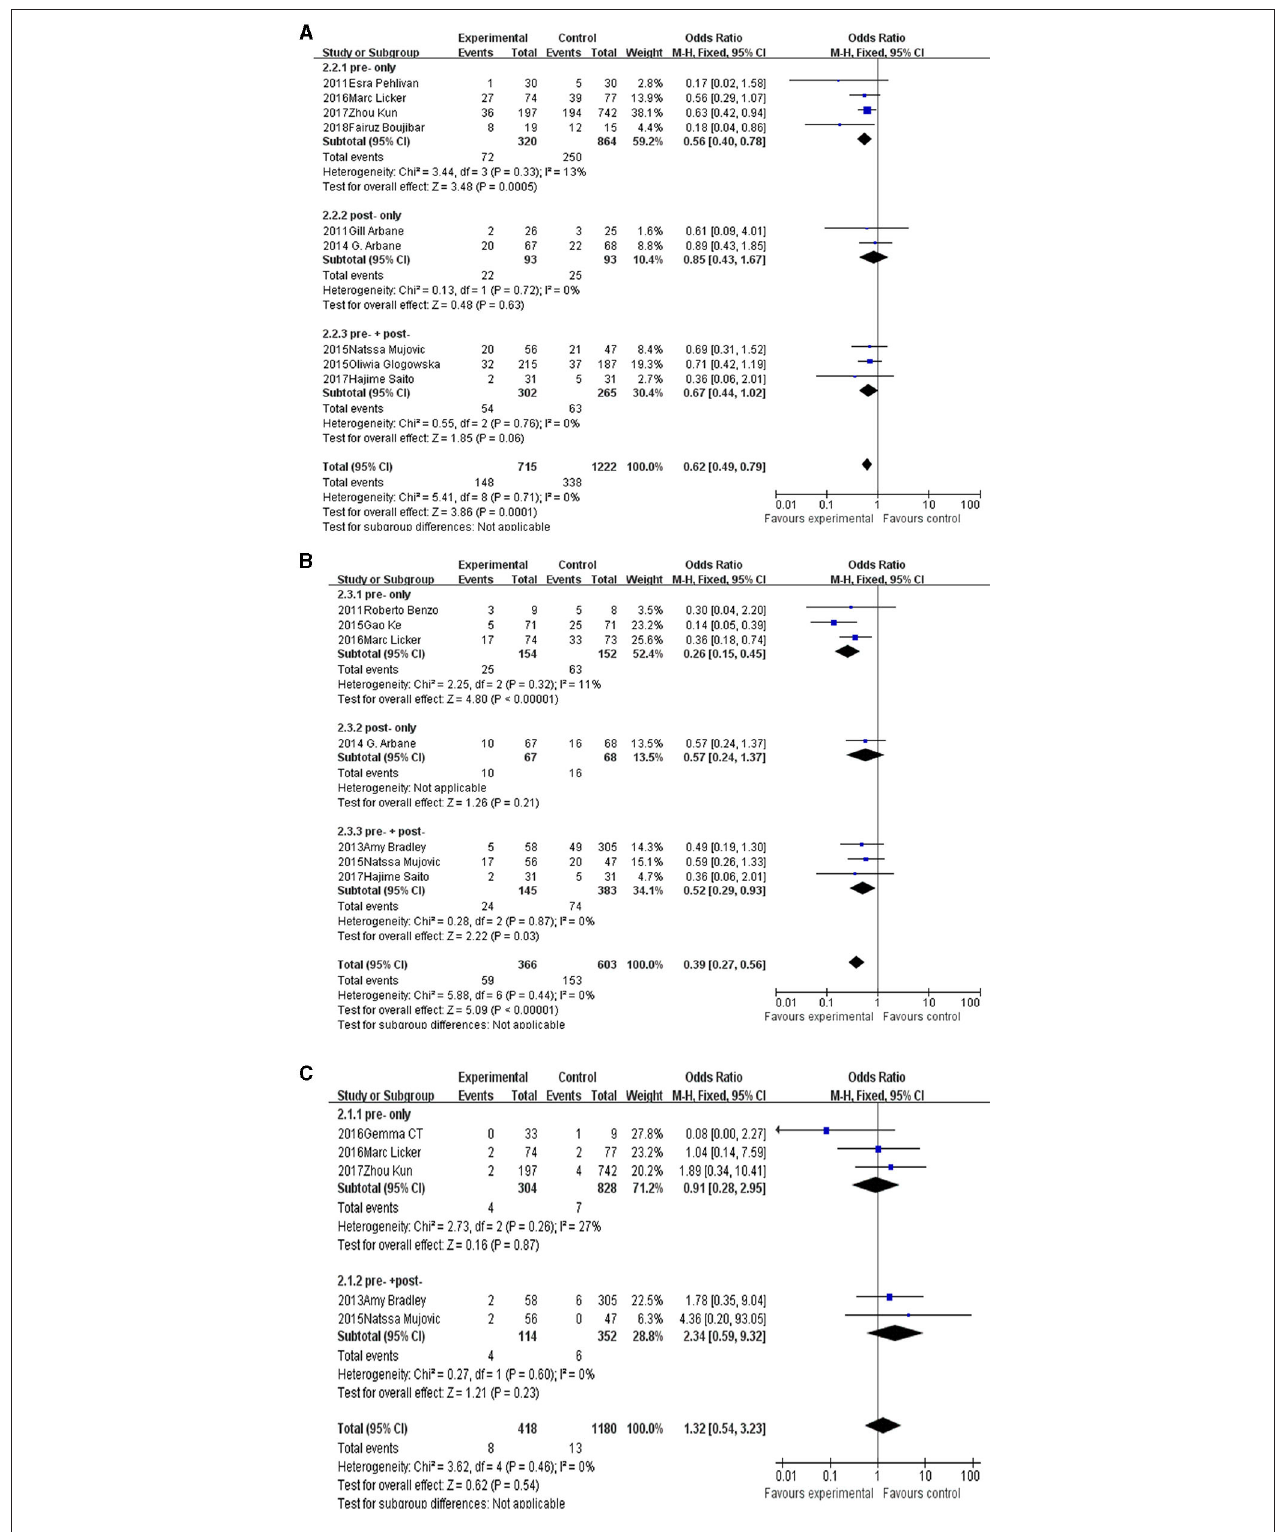
FIGURE 2 | The forest plot of postoperative complications (A) , postoperative pulmonary complications (B) , and mortality (C) .